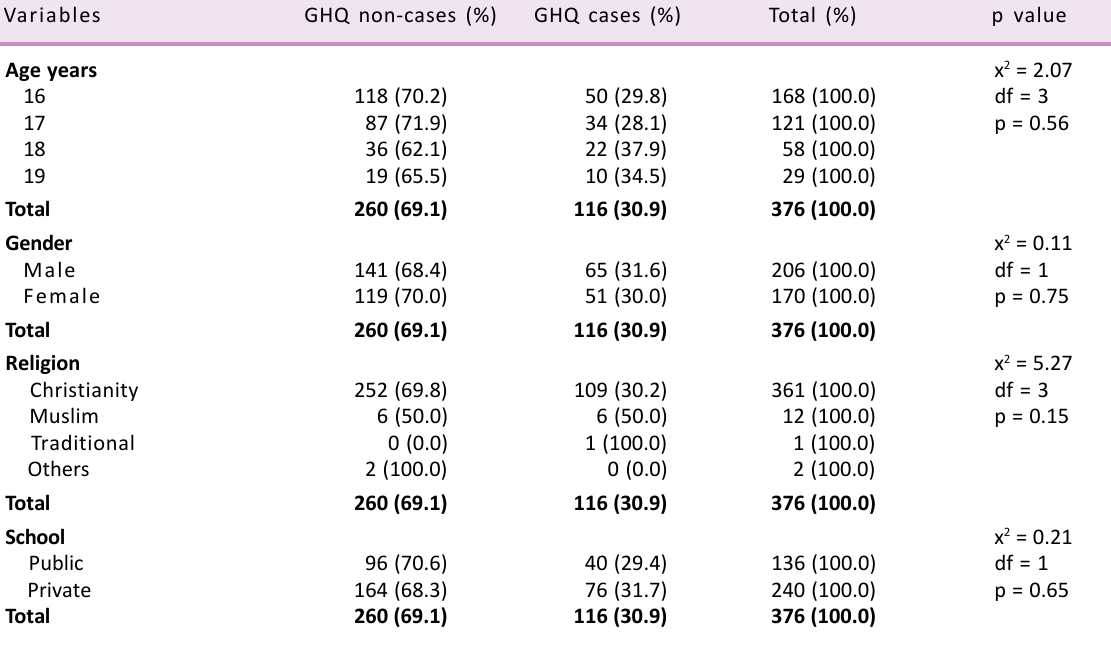
Table 1: Comparison of socio-demographic variables of GHQ non cases and cases